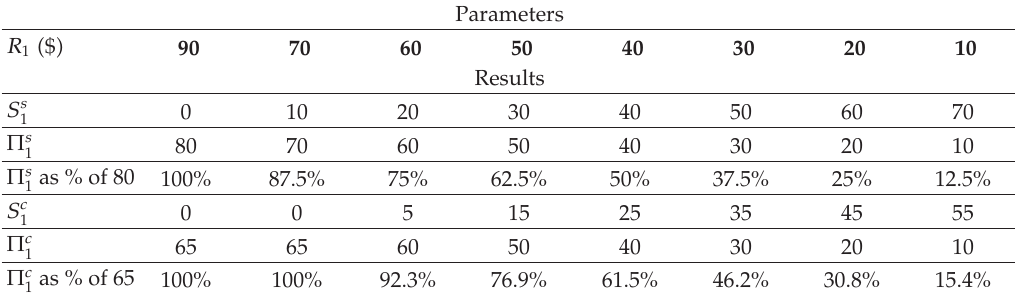
Table 3: Computational results, source (cid:6) 6 (cid:7)